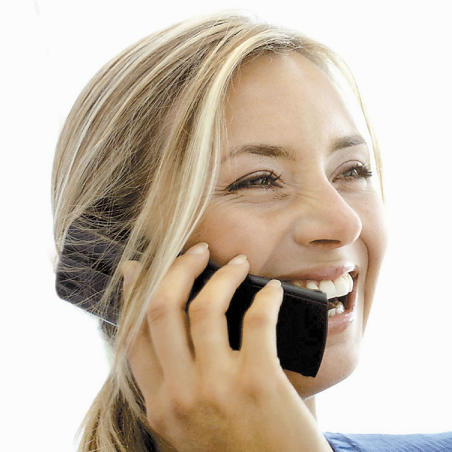
Recognizing people on the phone: Does knowing the face help? (Photo: copyright FEEI/FMK)